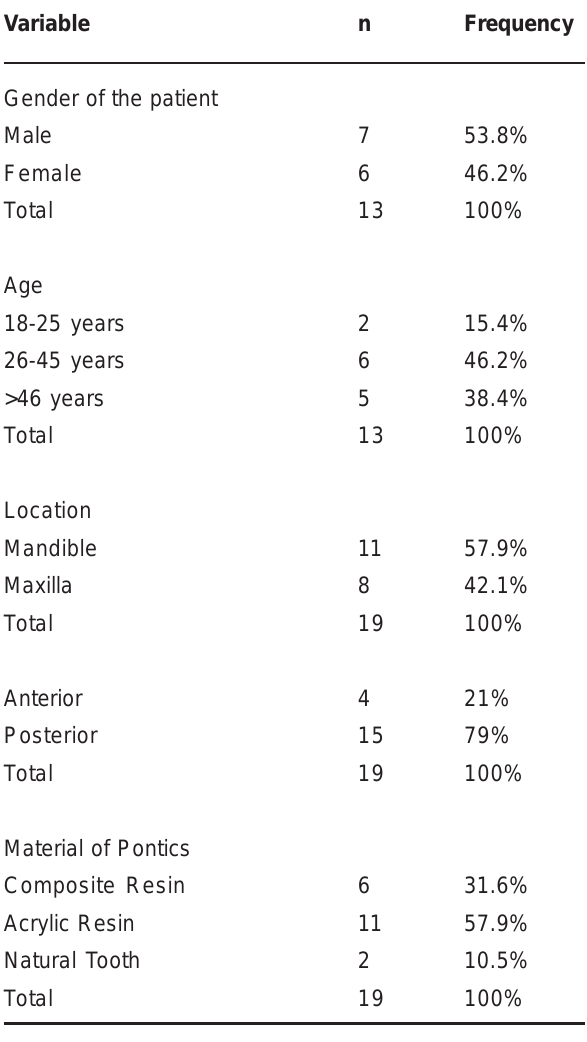
TABLE 2- Description of the variables for each patient